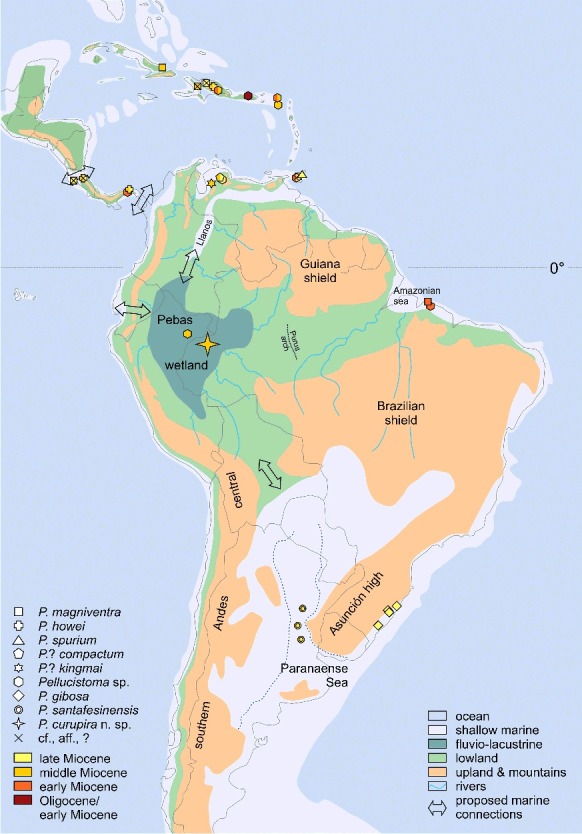
Tentative middle Miocene palaeogeography of the Caribbean realm and South America (based on Iturralde-Vinent & MacPhee 1999; Del Río 2000; Hernández et al. 2005; Hoorn et al. 2010b; Candela et al. 2012; extent of the Paranaense Sea probably too large (dashed blue line); compare Aceñolaza 2000; Cione et al. 2011; Ruskin et al. 2011) and Miocene records of Pellucistoma (the late Miocene P. magniventra (Florida) and P. aff. spurium (Bahamas) records are not displayed; compare Fig. 5).